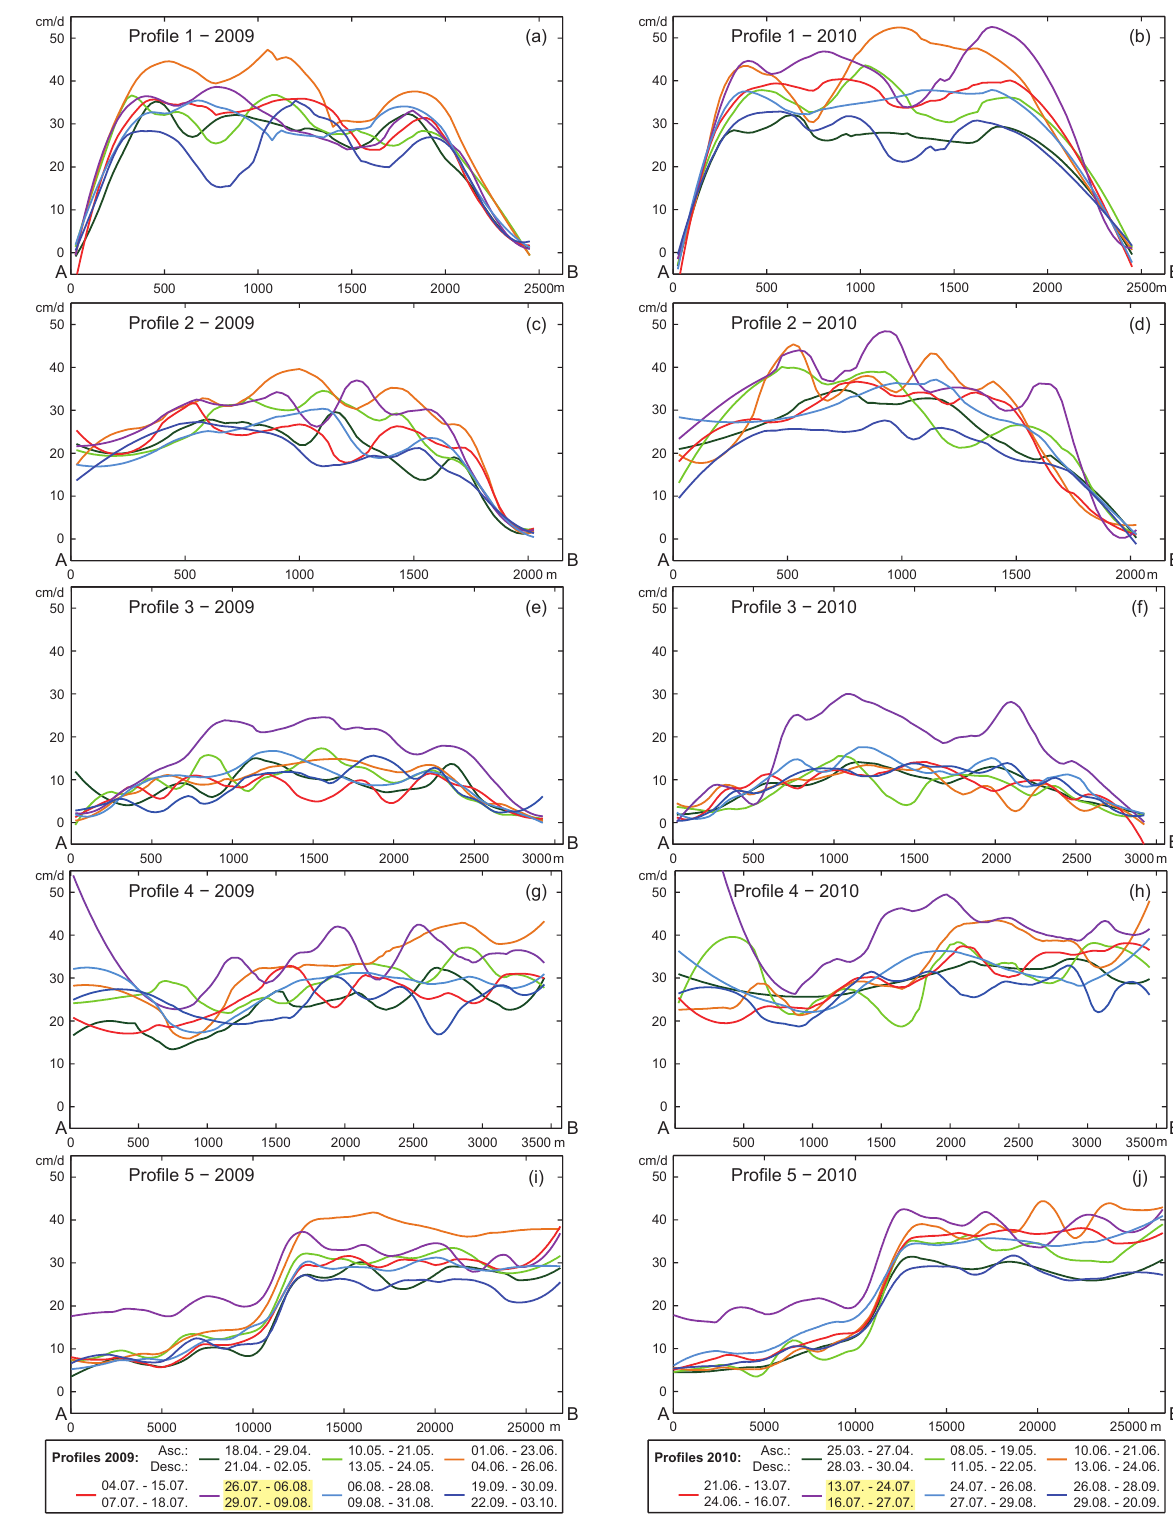
Figure 6. Seasonal velocity variations along three orthogonal ( a – f ) and two longitudinal ( g – j ) profile lines gained from kinematic map samples from 2009 and 2010, respectively. The alignment of the profiles 1–5 refers to the lines shown in Figure 4, whereas all profiles are running from A to B. Same colours represent a comparable time period; the exact time frame between the ascending and descending acquisitions can be extracted from the legend. The acquisitions covering the GLOF event are highlighted in